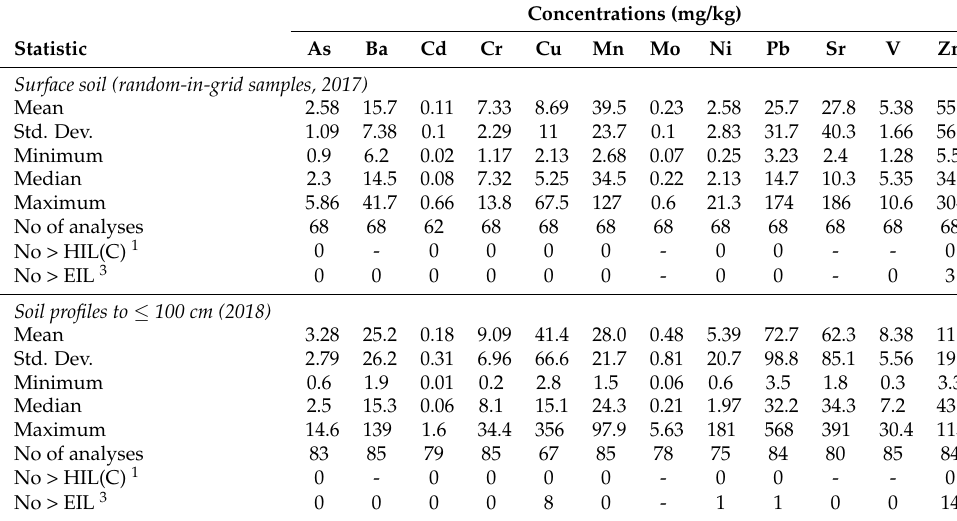
Table 2. Summary of minor/trace element concentrations in surface (0–10 cm) soil and in vertical soil profile samples at Smith’s Lake and Charles Veryard Reserves. Element concentrations were measured using aqua regia digestion followed by ICP-OES.